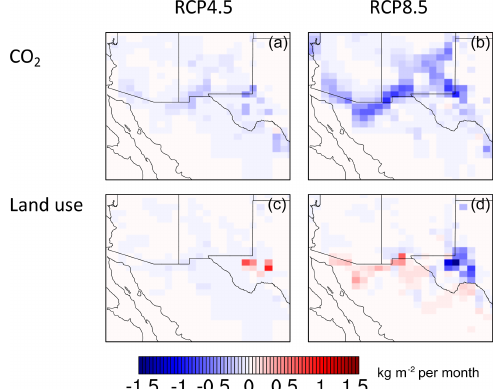
Figure 3. Contributions of CO 2 fertilization and land use change to changing dust emissions in spring in southwestern North America for RCP4.5 and RCP8.5. Changes are between the present day and 2100, with 5 years representing each time period. Panels (a) and (b) show the response of dust emission to only CO 2 fertilization, and panels (c) and (d) show the response to only trends in land use. Results are generated offline using the GEOS-Chem emission component (HEMCO).